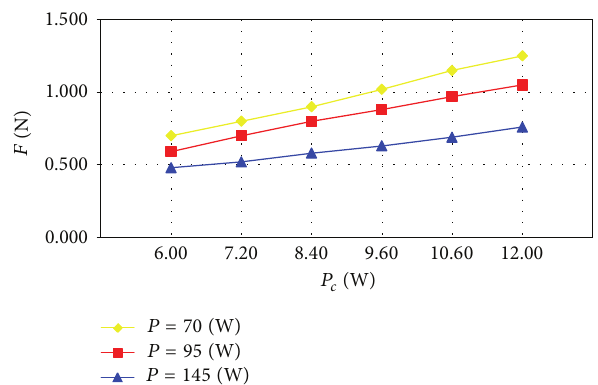
Figure 11: Lateral force variation due to the Coand˘a effect at con- stant values 𝑝 = 4 ∘ and 𝛿 = 2 mm.